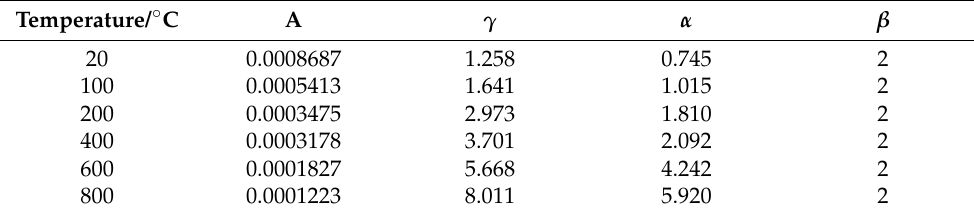
Table 6. Parameters for high-temperature damage constitutive equation for concrete. Temperature/ ◦ C